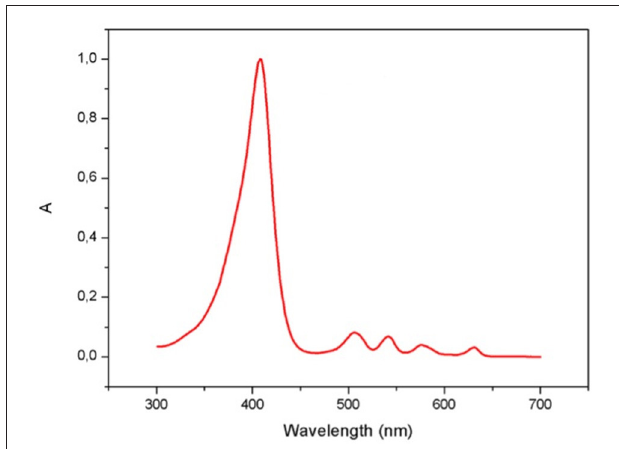
FIGURE 2 | Measured transmittance for each of the six tested products. Transmittance of substrates is calculated as percent of the baseline transmittance of each PMMA plate before sample application (T%).